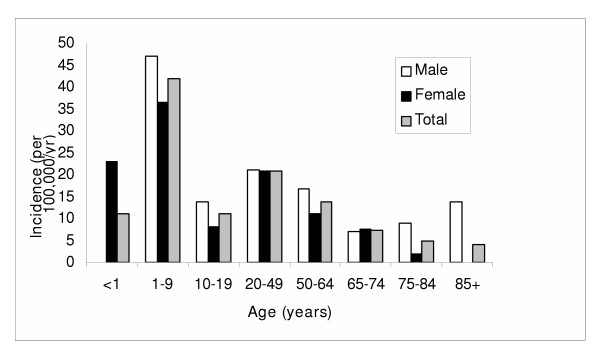
Age and gender specific incidence rates of Giardia sp. infection in the Calgary Health Region.